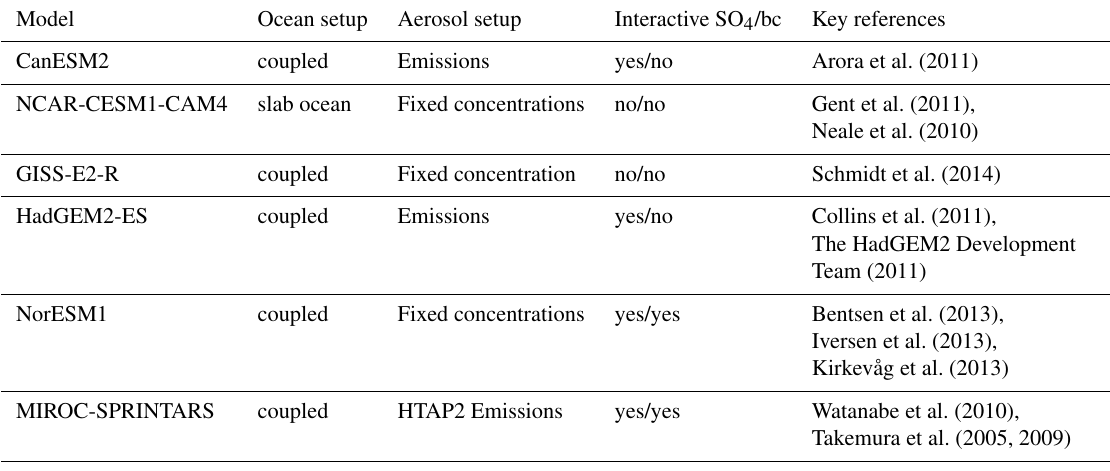
Table 1. PDRMIP models used in this study, ocean and aerosol configuration of the model, and which aerosol–cloud interactions are included.